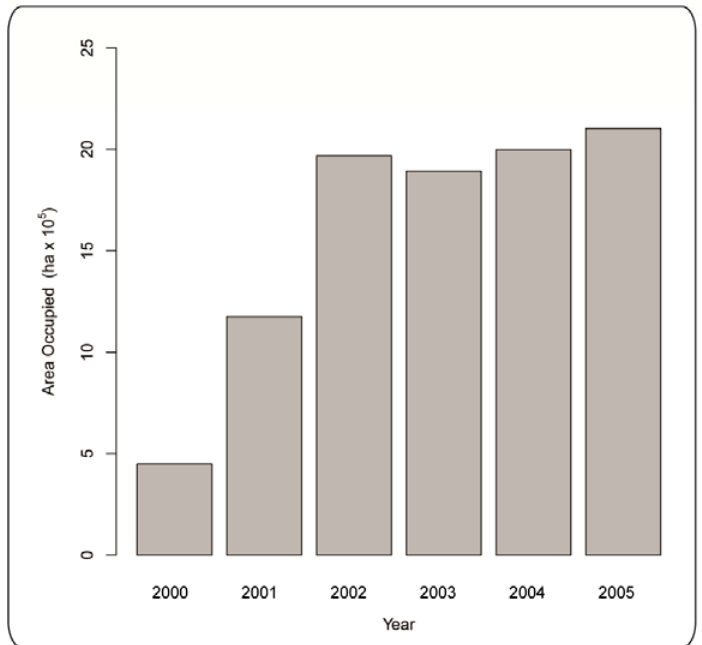
Figure 3. Area occupied by mountain pine in study site during recent epidemic. Note that the Area Occupied ( y -axis) reflects the number of 1 ha cells that contain at least some proportion of beetle-induced tree mortality. The total area of British Columbia covered by forest land is approximately 60 million